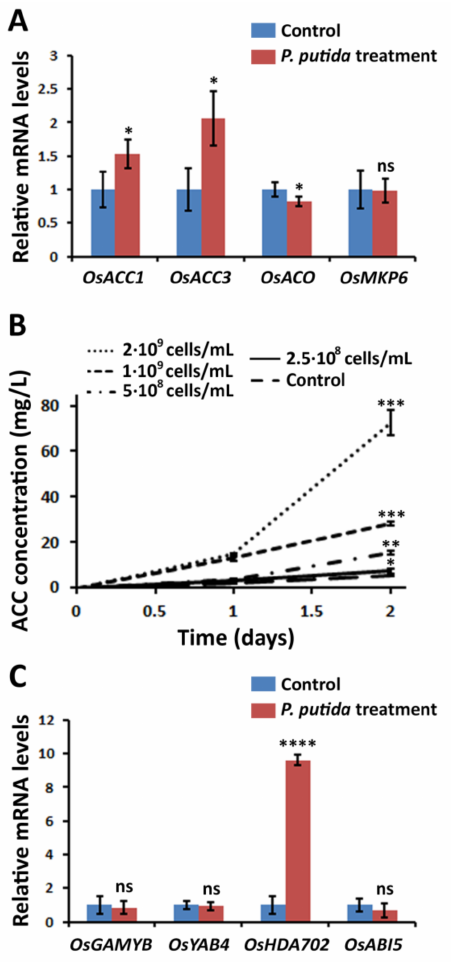
Figure 2. Metabolic alterations produced by P. putida in rice plants. ( A ) Relative mRNA levels of ethylene (ET) biosynthesis and signaling genes in the presence and absence of P. putida . ( B ) Concentration of 1-amino-1-carboxylic acid (ACC) in rice culture medium in the presence and absence of P. putida . ( C ) Relative mRNA levels of gibberellic acid (GA) and abscisic acid (ABA) signaling genes in the presence and absence of P. putida . Significance levels at p < 0.05 (*), p < 0.01 (**), p < 0.001 (***), p < 0.0001 (****) and no significance